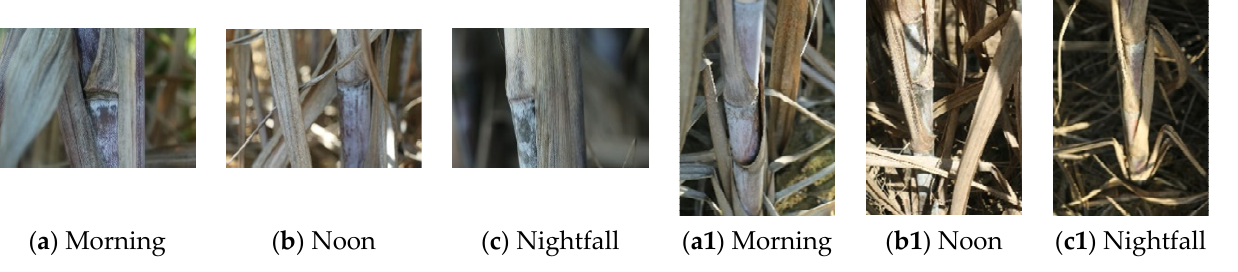
Figure 2. Collected image dataset.